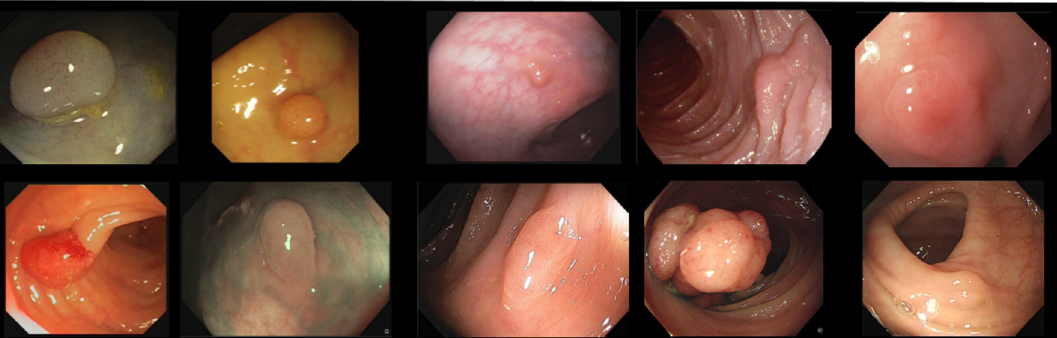
Figure 2. Examples of polyp images from the included datasets. Upper row (left to right): CVC- ClinicDB, CVC-ColonDB, CVC-PolypHD, ETIS-Larib, and Kvasir-SEG. Bottom row (left to right): CVC-ClinicVideoDB, PICCOLO, KUMC, SUN, and LDPolypVideo.